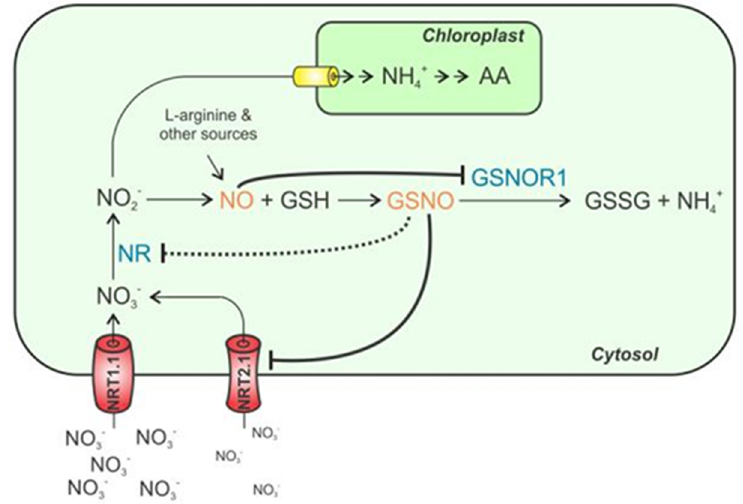
Figure 2. The proposed mechanism for control of the Nitrogen assimilation pathway [30] GSNOR activity is thought to increase NRT2.1 and NR function thereby leading to eventual increases in NO levels, which are ultimately thought to have an inhibitory effect on GSNOR.